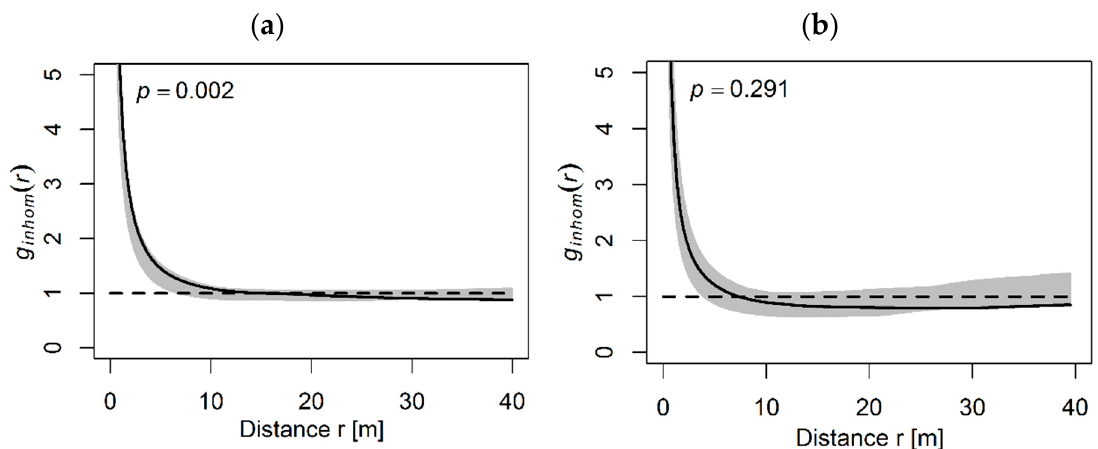
Figure 3. Spatial pattern (pair correlation g(r)) of all P. cembra L. individuals from the Natura 2000 site ( a ) and the Retezat National Park ( b ). The solid line shows observed g(r) values, the dashed line denotes the totally random distribution curve (HP) and the gray area represents the 95% confidence interval.